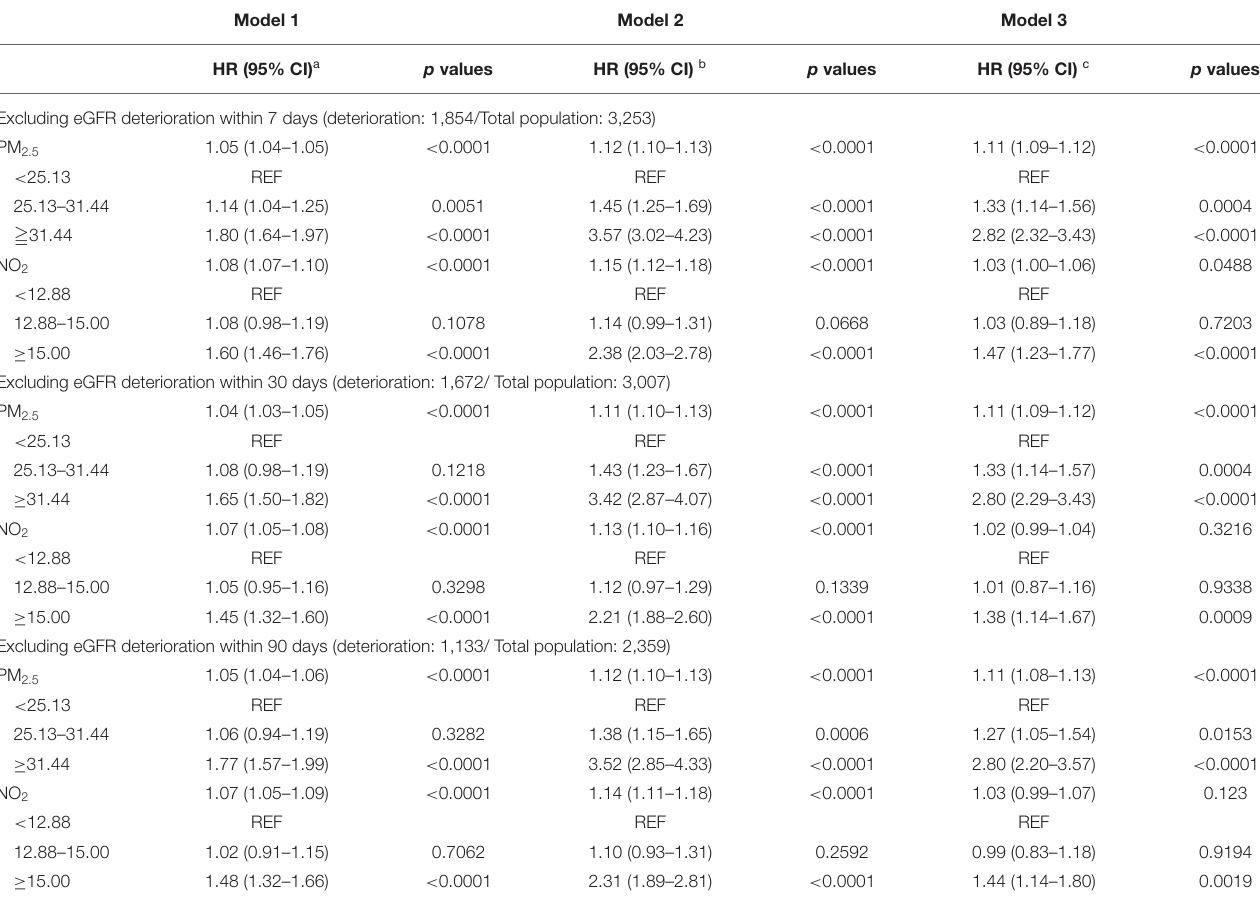
TABLE 3 | Sensitivity analysis for associations between PM 2.5 and NO 2 as well as deterioration in pre-end-stage renal disease (pre-ESRD)